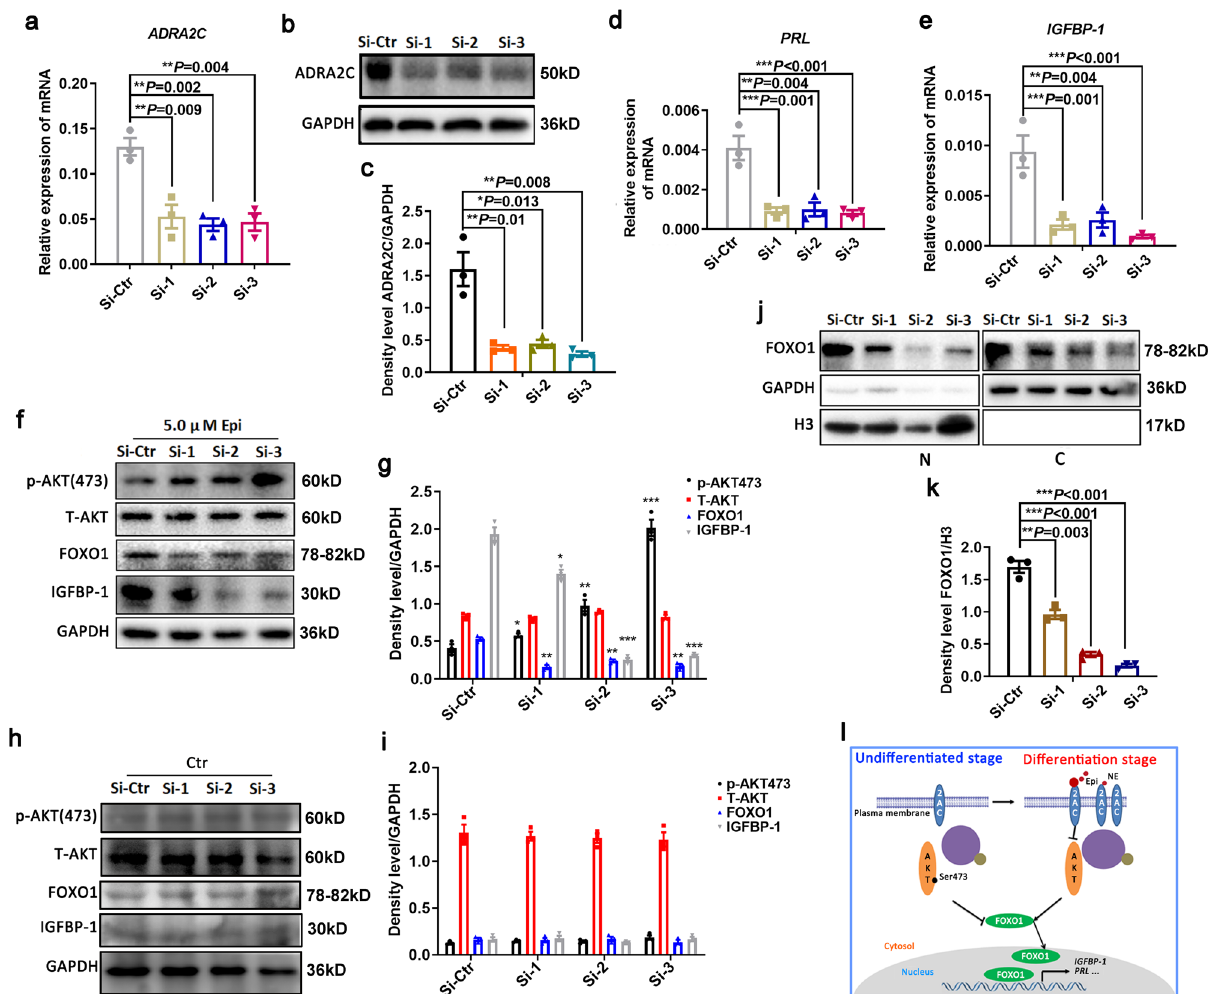
Fig. 5 Knockdown of ADRA2C abolished the promoting effect of adrenergic signal-mediated decidualization of HESCs. a , b The mRNA and protein expression level for knockdown ef fi ciency of ADRA2C in HESCs. c Relative fold change in density levels for b . d , e The mRNA level for PRL and IGFBP-1 transcription in the presence of epinephrine after ADRA2C knockdown. Values were normalized to GAPDH expression level and indicate as the mean ± SEM, n = 3. f Western blot for the activity of AKT and the expression of FOXO1 in the presence of epinephrine after knockdown of ADRA2C. g Relative fold change in density levels for f . h Western blot for the activity of AKT and the expression of FOXO1 in the absence of epinephrine after knockdown of ADRA2C. i Relative fold change in density levels for h . j Western blot for FOXO1 expression in different cellular compartments in the presence of epinephrine after ADRA2C knockdown. k Relative fold change in density levels for j . l Schematic diagram of ADRA2C mediated epinephrine signaling in HESCs during